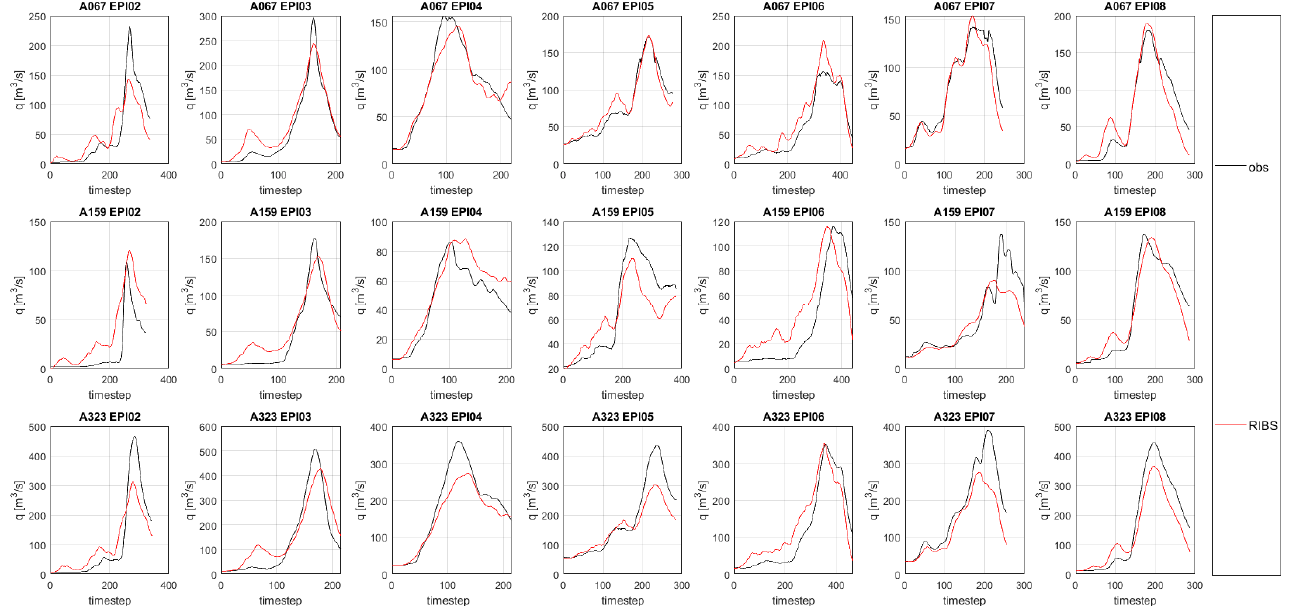
Figure 6. Comparison between observed (black) and simulated (red) hydrographs for the calibration and validation flood events with the parameter values selected in the calibration process. Columns show flood events. Rows show streamflow gauging-sites.